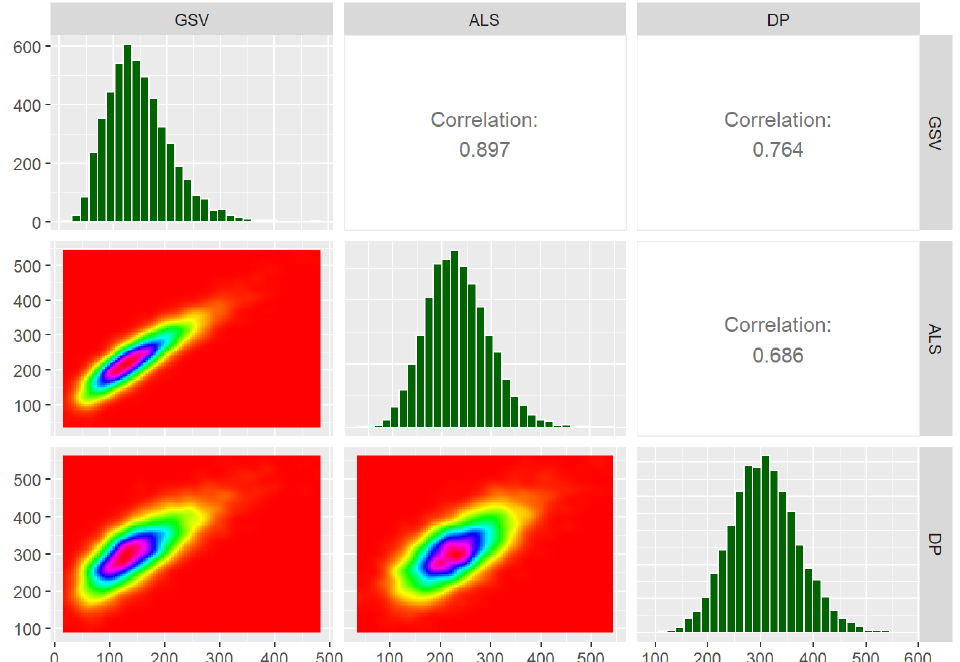
Figure 2. Summary of simulated data. GSV is the plot level growing stock volume (m 3 ha − 1 ), ALS is the metric from airborne laser scanning, and DP is the metric from digital aerial photogrammetry.